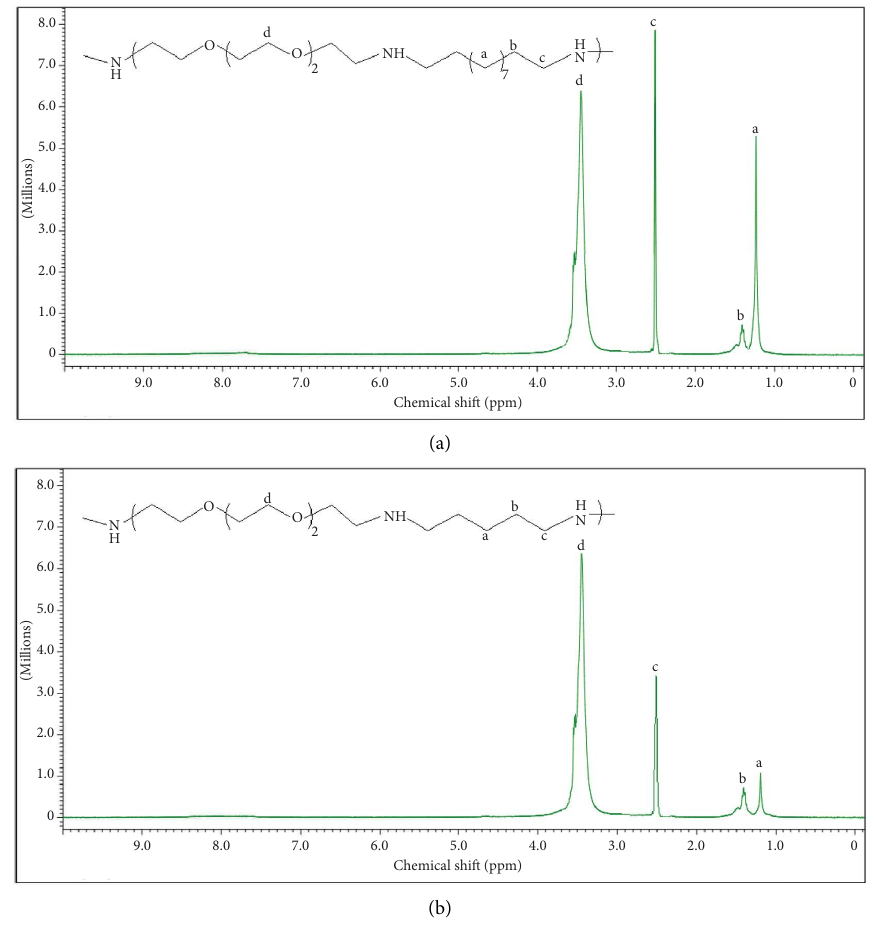
Figure 2: 1 H-NMR spectra of (a) AH-UD and (b) AH-PD